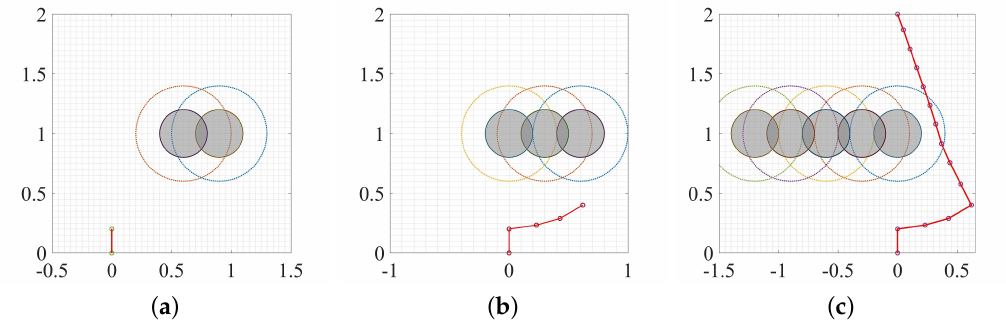
Figure 9. The robot uses the dynamic window based artificial potential field (DVAPF) approach to avoid a fast moving obstacle: ( a ) before avoiding; ( b ) avoiding the obstacle; and ( c ) finish avoiding.